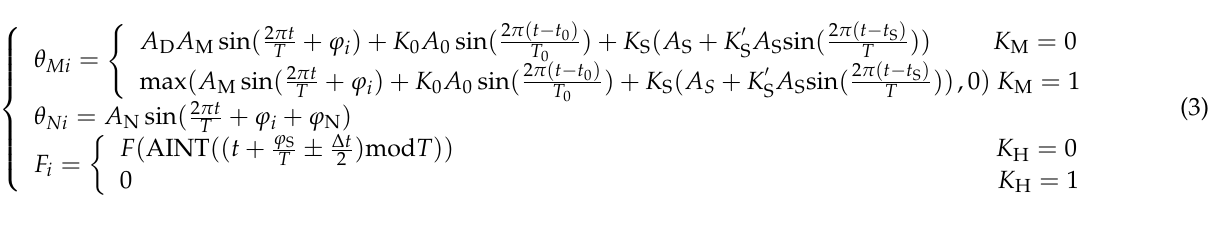
Figure 2. Overall diagram of the CPG control system.